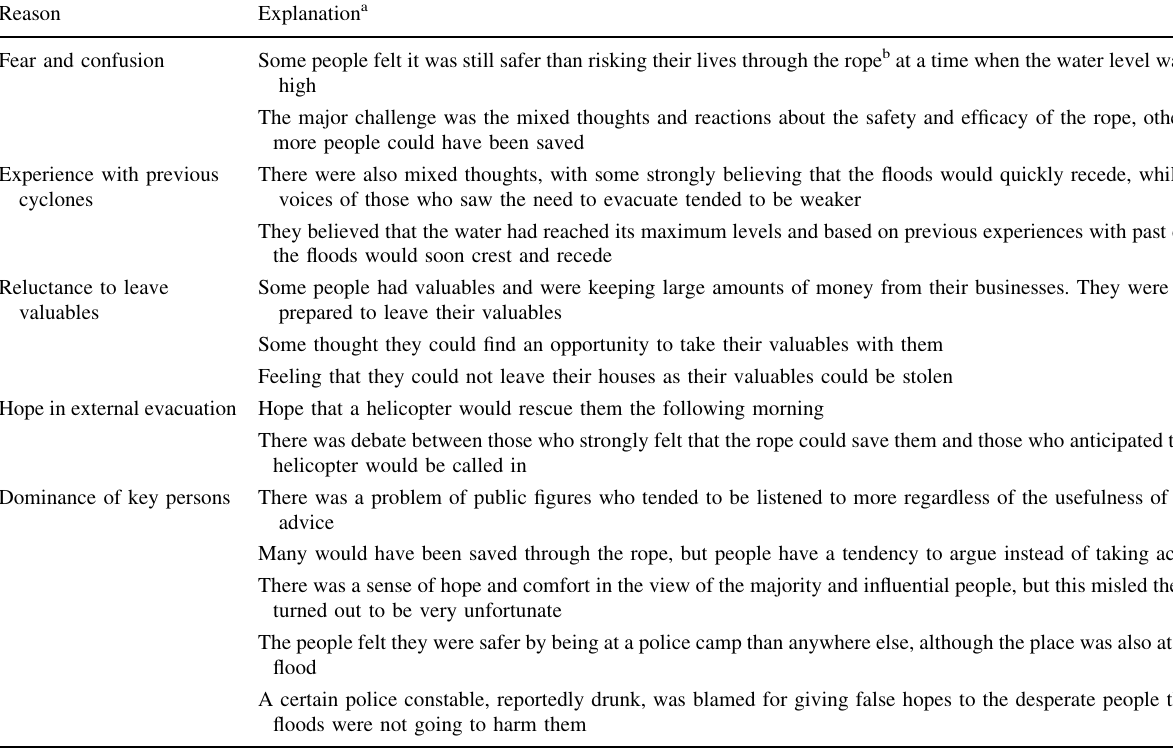
Table 1 Reasons for disregarding local early warnings. Source : Survivors’ responses 2019